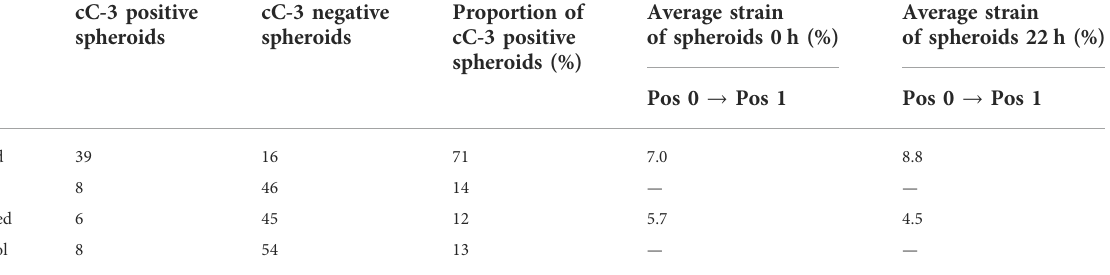
TABLE 1 Quanti fi cation of cleaved caspase 3 (cC-3) positive spheroids and applied strain.